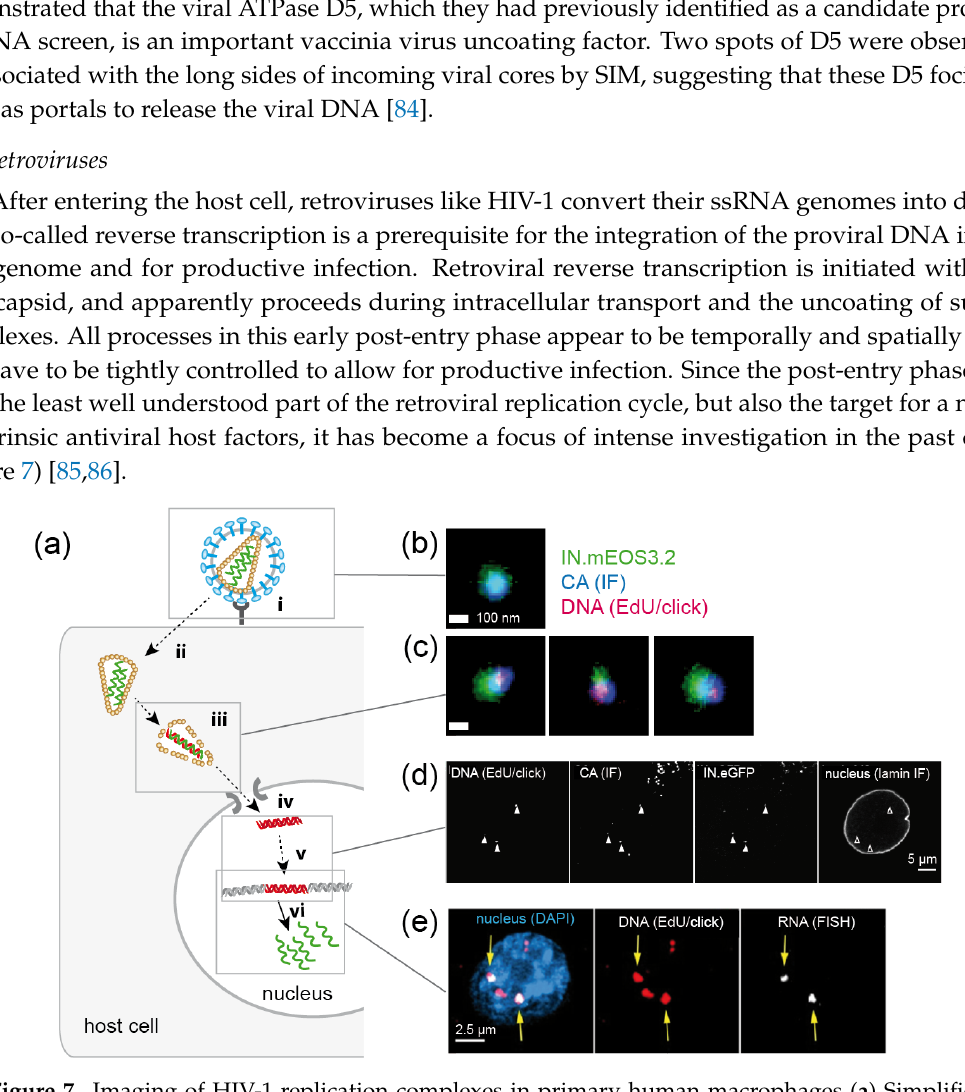
Figure 7. Imaging of HIV-1 replication complexes in primary human macrophages ( a ) Simplified schematic representation of post-entry replication stages of HIV-1. The virus attaches to receptor and co-receptor molecules at the host cell surface (i), and the viral Env protein mediates fusion of the viral envelope with a host cell membrane, resulting in cytosolic entry of the conical capsid (ii). Reverse transcription of the viral genome, transport to the NPC and capsid uncoating (iii) are spatially and temporally intertwined; this part of the replication cycle is poorly understood. A viral nucleoprotein complex is transported through the NPC into the nucleus (iv), where the viral cDNA is integrated into the host cell genome (v) and serves as a template for transcription of viral RNA (vi). Green, RNA; red, DNA. ( b , c ) Nanoscopic visualization of HIV-1 particles ( b ) and cytosolic subviral complexes ( c ). Three-color PALM/dSTORM images reveal co-localization of nascent HIV-1 DNA in reverse transcription complexes with the viral proteins CA and integrase [68]. ( d ) HIV-1 CA is detected at viral reverse transcription complexes in the nucleus of infected primary macrophages by confocal microscopy [67]. ( e ) Newly transcribed HIV-1 RNA co-localizes with a subset of EdU/click labeled HIV-1 DNA in the nucleus (arrows) [69]. Images in ( b – e ) were modified from the indicated references, with